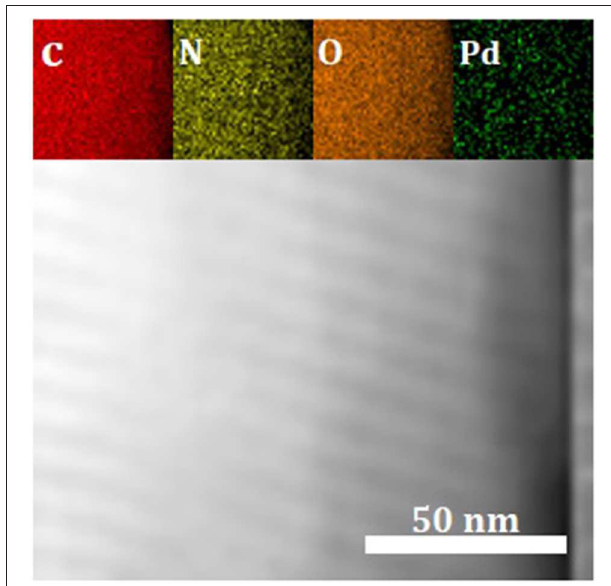
FIGURE 6 | EDX maps of C, N, O and Pd elements for 1Pd/NOMC − 0.3–750 according to the corresponding TEM image.